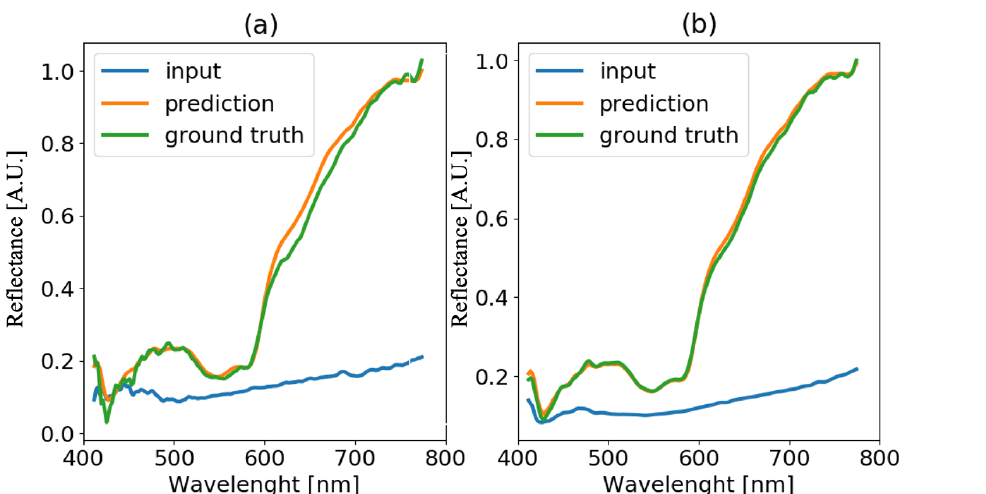
Figure 11. Blood spectra ( a ) and averaged blood spectra ( b ) comparison for the sample on black paper substrate and acquired at time t = 50